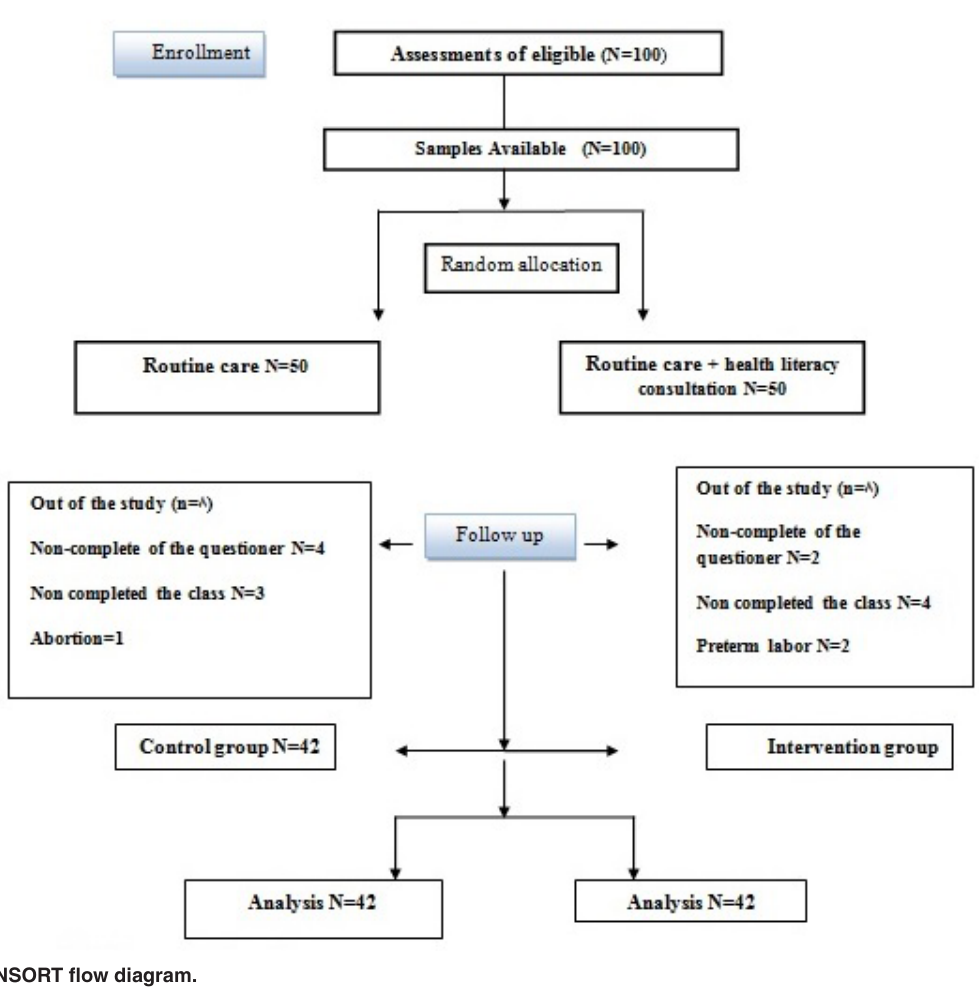
Figure 1. CONSORT flow diagram.